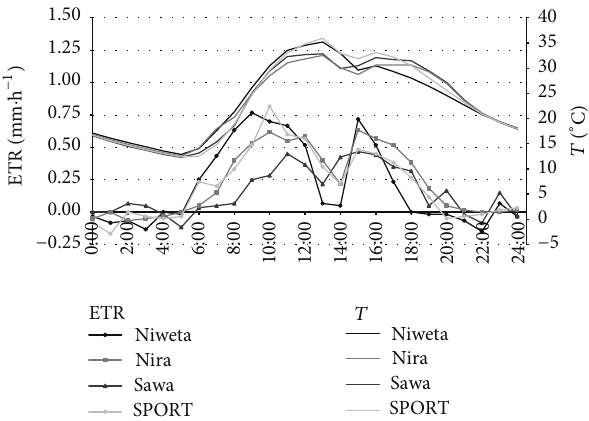
Figure 5: Diurnal dynamics of evapotranspiration and temperature for the four grasses on 13.06.2013 calculated with time step of Δ𝑡 = 1h; ETR is evapotranspiration and 𝑇 is soil temperature at the depth of 2.5